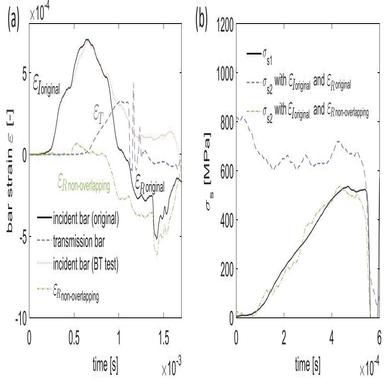
Bar strain wave group of SHTB UNT test (a) and dynamic stress equilibrium check (b).